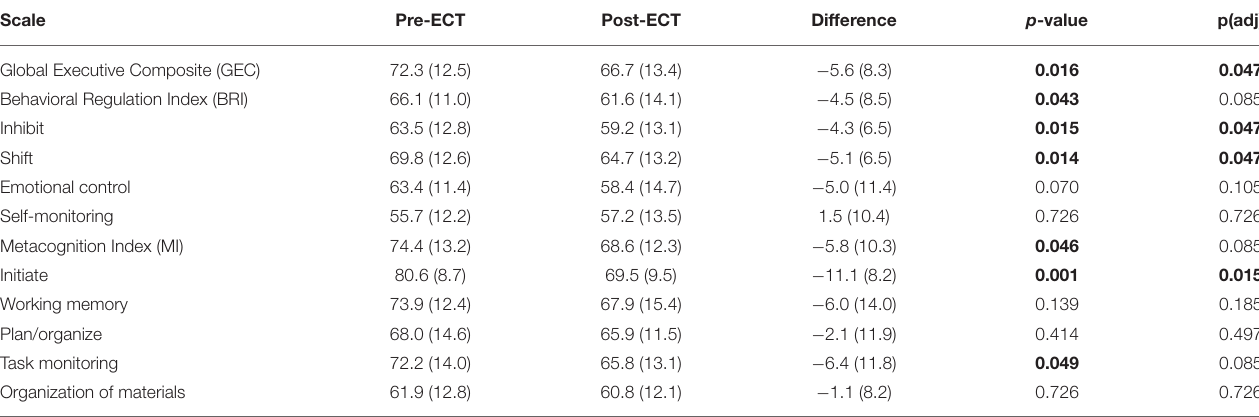
TABLE 2 | Behavior rating inventory of executive function—adult version (BRIEF-A) T-scores pre- and